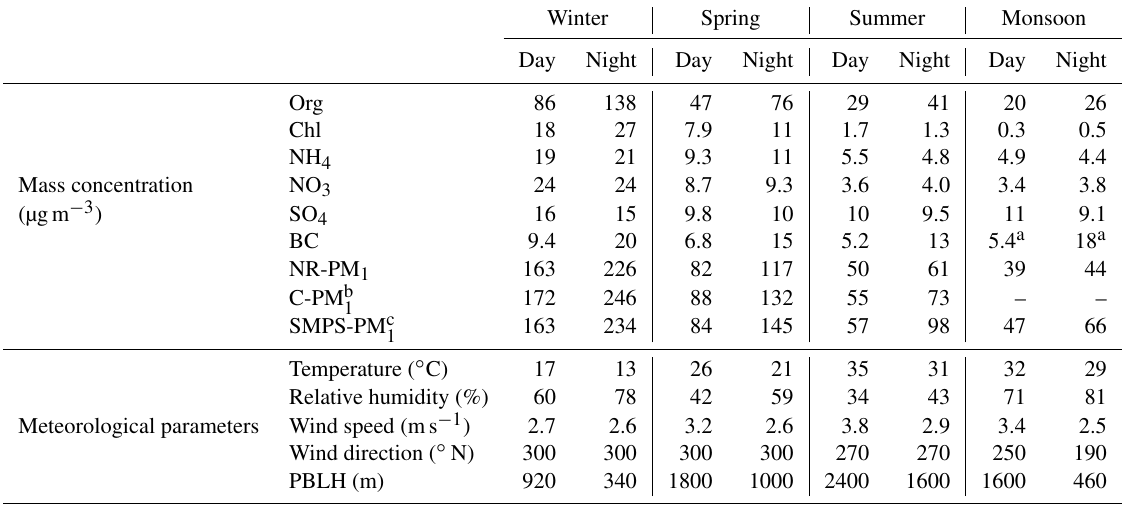
a Based on limited BC data for the monsoon due to instrument downtime. b Composition-based estimate of PM using hybrid PSD and assuming a density of 1.6gcm − 3 .